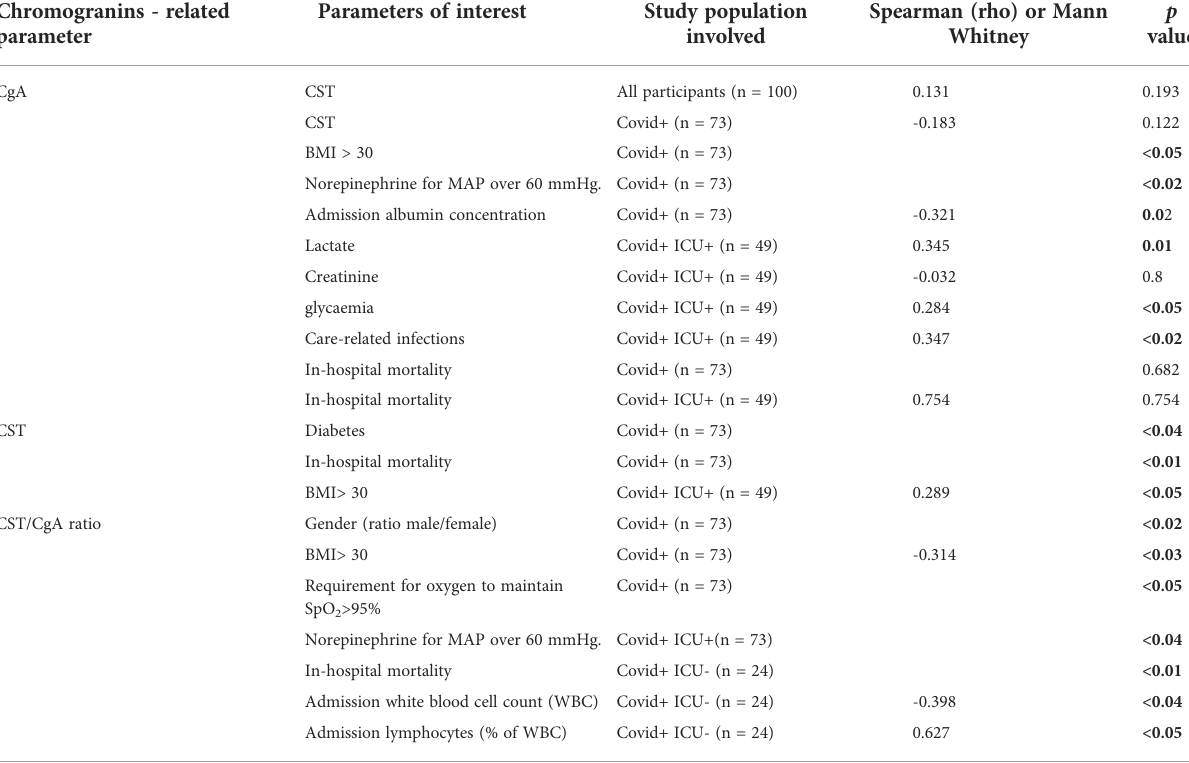
TABLE 3 Univariate analyses and correlations between chromogranins and clinical data (from all participants or subgroups, as indicated). Bold values correspond to signi fi cative p value. Chromogranins -